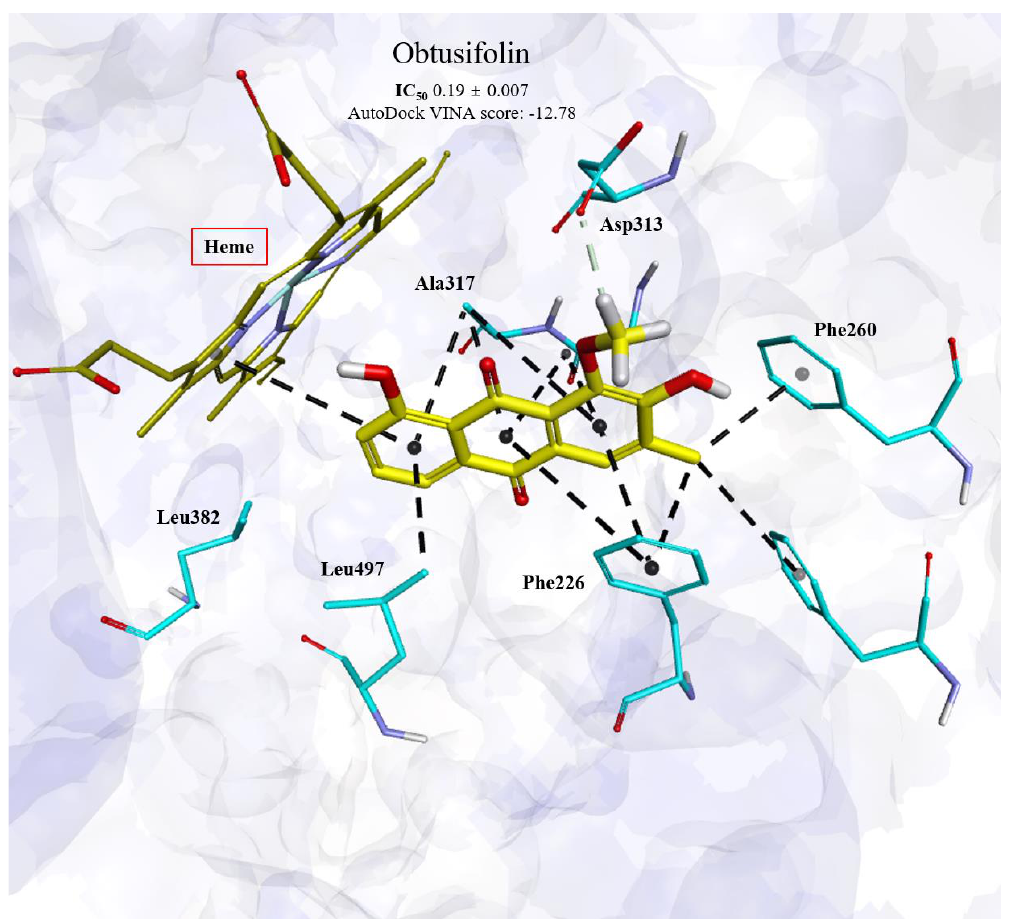
Figure 3. Molecular docking pose of obtusifolin in CYP1A2 (PDB ID: 2HI4). The carbon atoms of the interacting residues in CYP1A2 are displayed as cyan sticks and labeled. Heme is represented by red sticks. The carbon atoms in the ligand are shown as yellow sticks. The non-classified hydrogen bond and hydrophobic interactions are depicted by light green and black dotted lines, respectively. Leu382 is highlighted to demonstrate that steric bump formation with the ligand is not possible (Please find more details in the Discussion